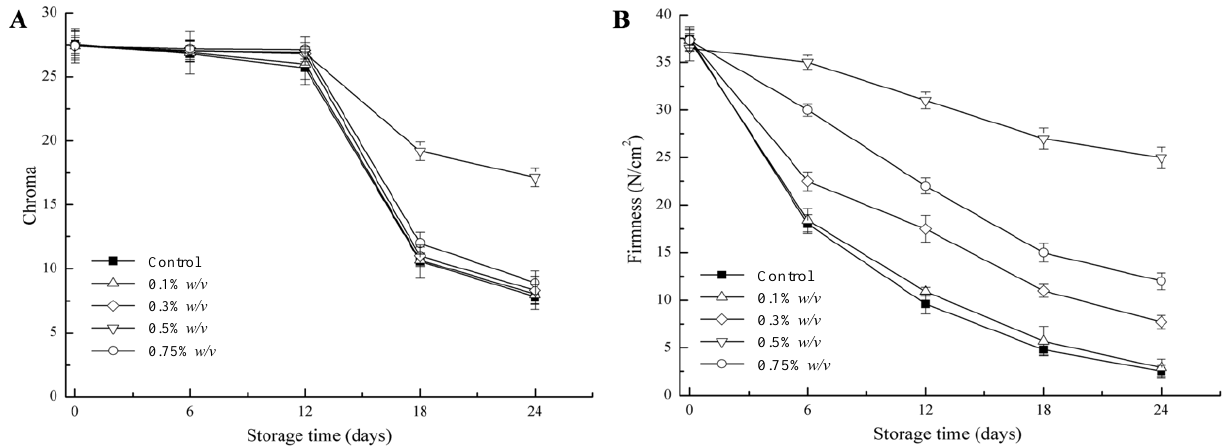
Figure 1. Change of chroma ( A ) and firmness ( B ) in sweet cherry stored at 10 °C during storage time. The data are the means ± standard-deviation (SD).